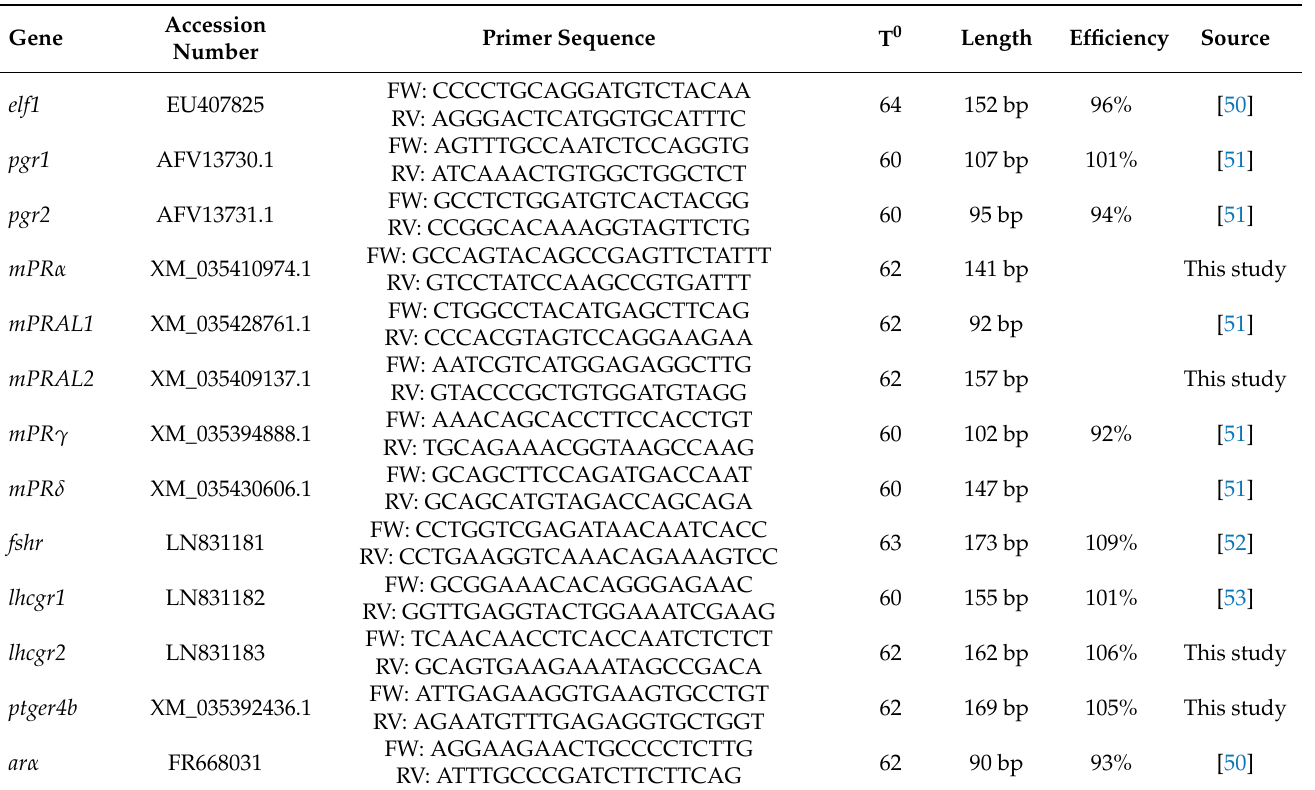
Table 1. Primers used for each target gene. T 0 : annealing temperature; bp: base pair. The primer efficiency of mPR α , mPRAL1, mPRAL2, mPR δ and lhcgr2 could not be determined, since the